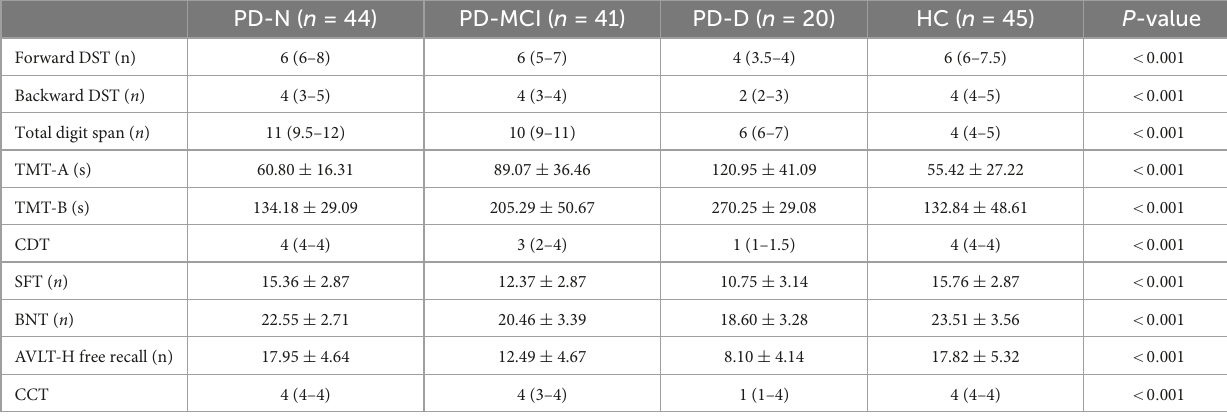
TABLE 2 Comparison of neuropsychological test results between the PD groups and the HC